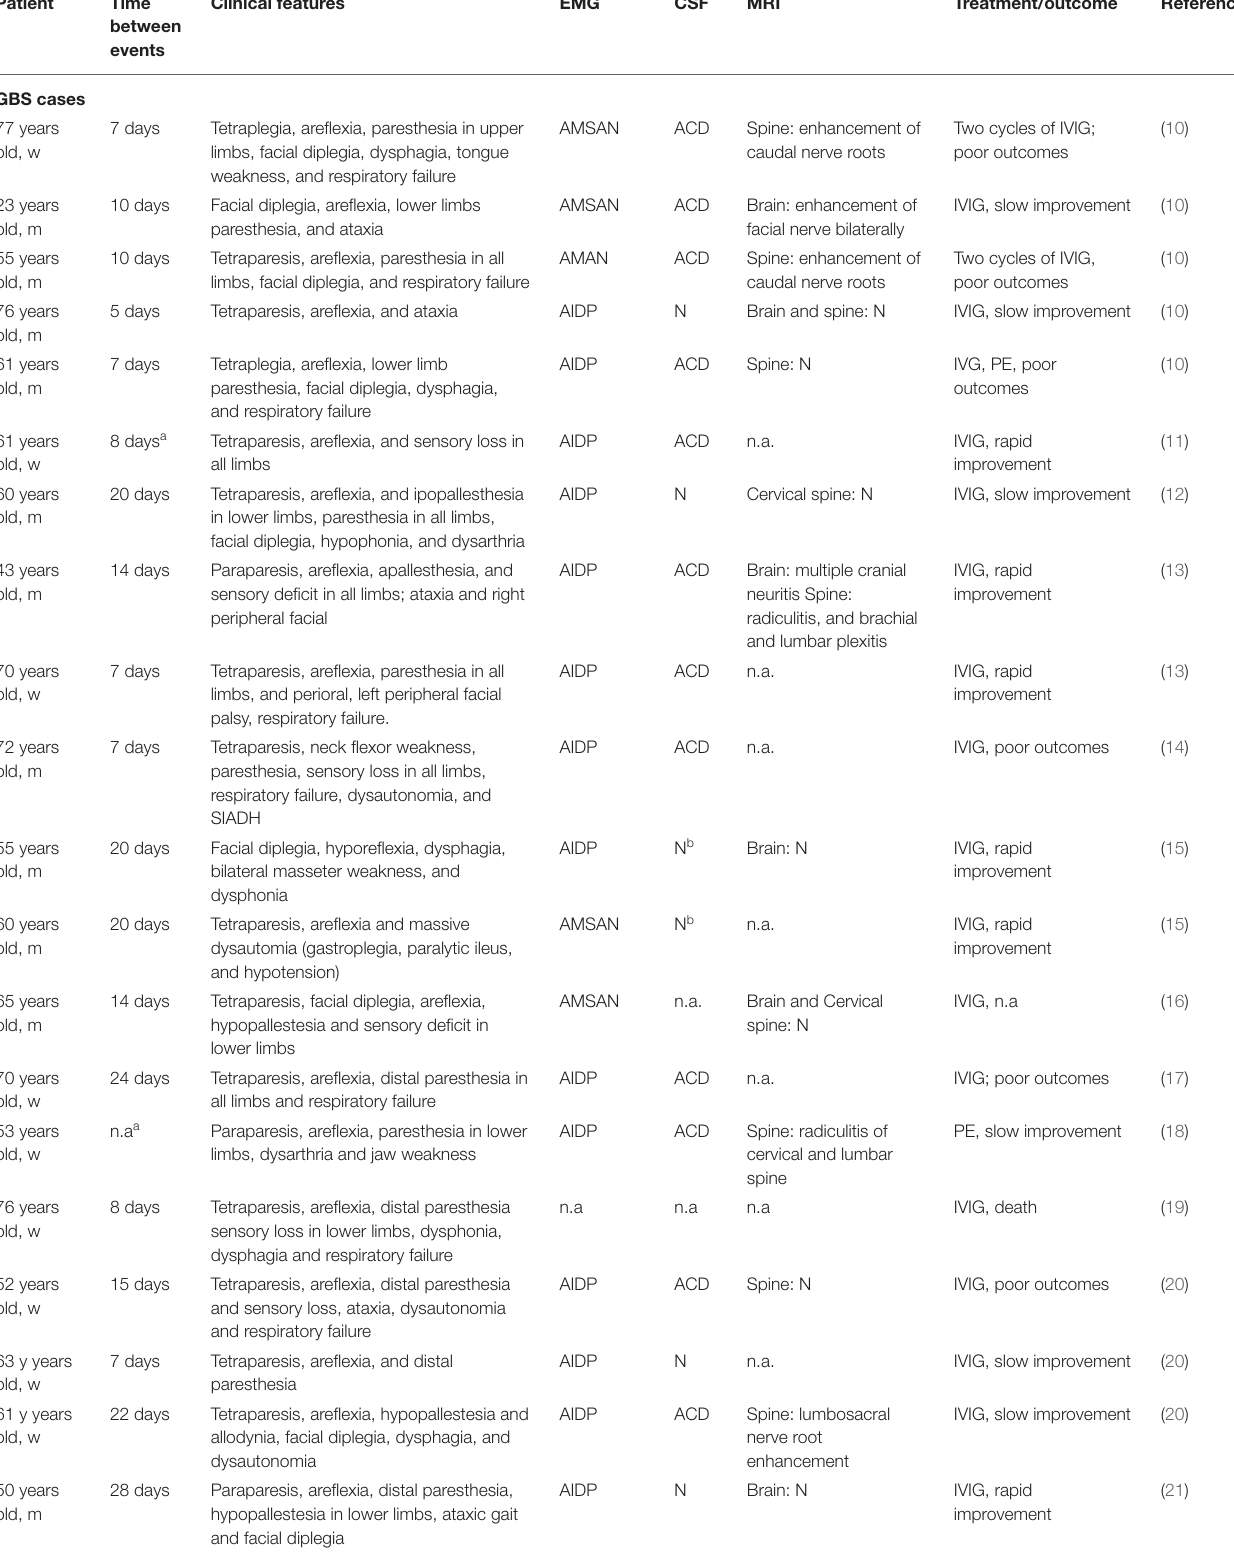
TABLE 2 | Guillain–Barré syndrome (GBS) cases related to SARS-CoV-2. Patient Time